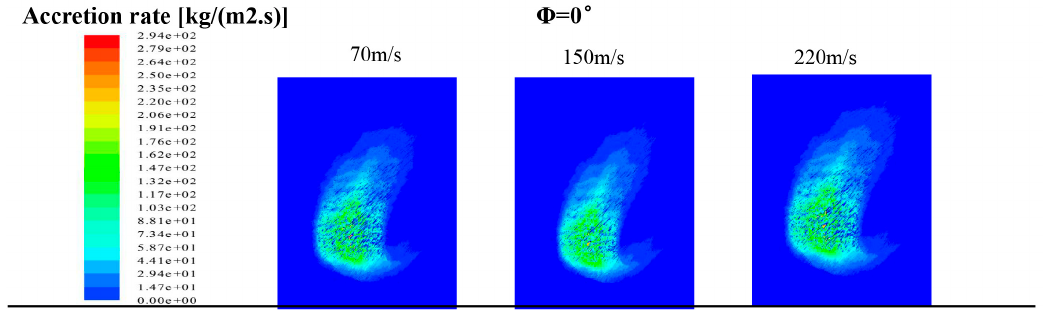
Figure 7. Three-dimensional accretion rates at different impact speeds at 0° angle of attack.